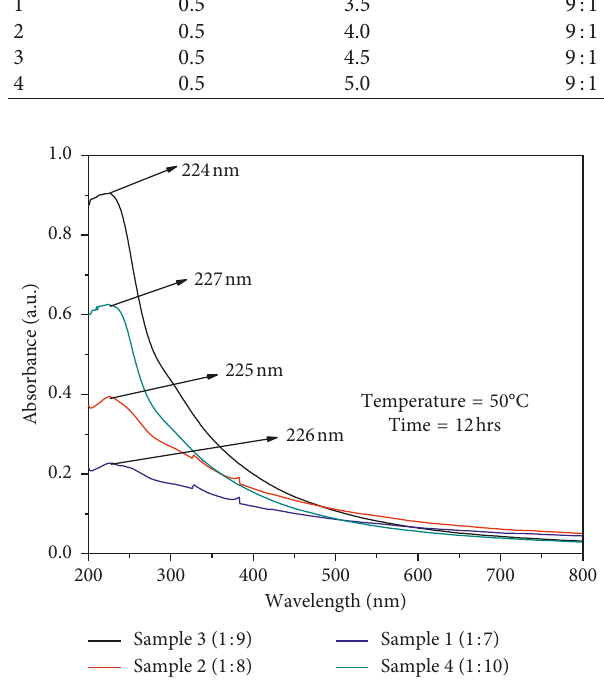
Figure 1: UV-Vis spectra at different